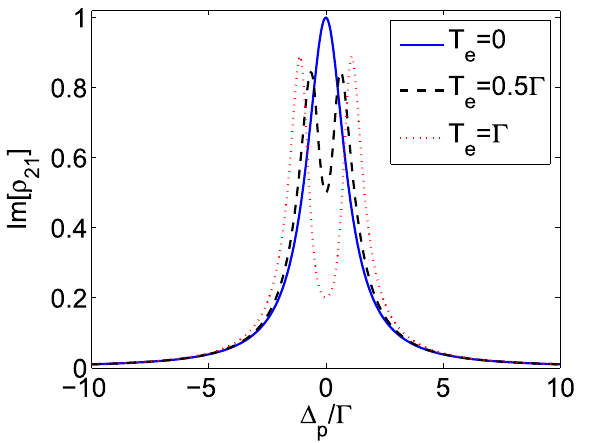
Figure 3. Imaginary part of ρ 21 as a function of � p /Ŵ . Used parameters are Ŵ 2 = Ŵ 4 = Ŵ , � p = 0.1 Ŵ , � c = 0.5 Ŵ , and (cid:31) c = 0